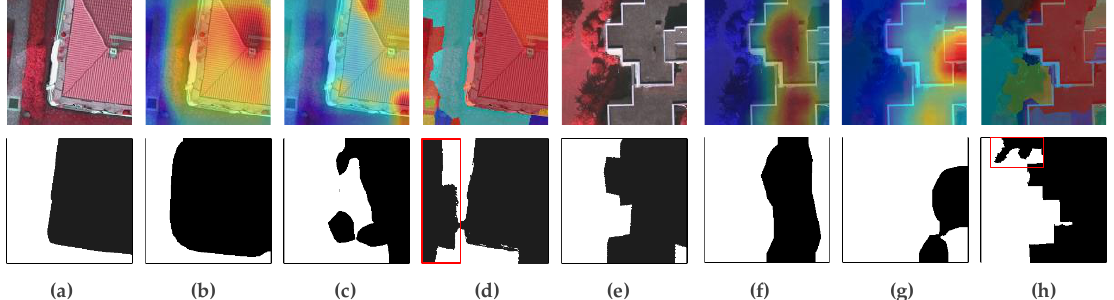
Figure 3. Pseudo-labels of building. (a) and (e) are the input image and ground truth respectively; (b) and (f) are the heatmaps of CAM and its generated pseudo-label; (c) and (g) are the heatmaps of WILDCAT and its generated pseudo-label; and (d) and (h) are the heatmaps of SPMF-Net and its generated pseudo-label. (a – d) are from the Potsdam dataset, (e – f) are from the Vaihingen dataset. Buildings are represented by black color, and other classes are represented by white color.